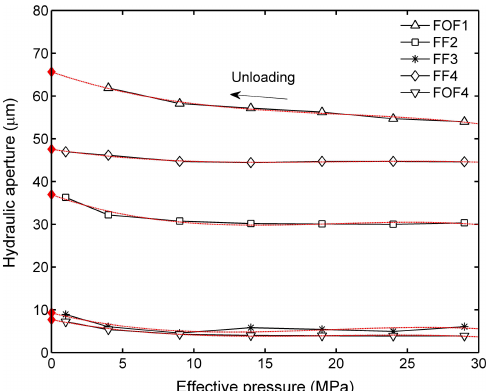
Figure 4. Hydraulic aperture a FTA (obtained by the flow-through apparatus) as a function of effective pressure during unloading. Each point is a steady-state permeability measurement at the respec- tive effective pressure. The fitted curves (red lines) represent the hy- draulic aperture of each fractured sample at zero effective pressure (red